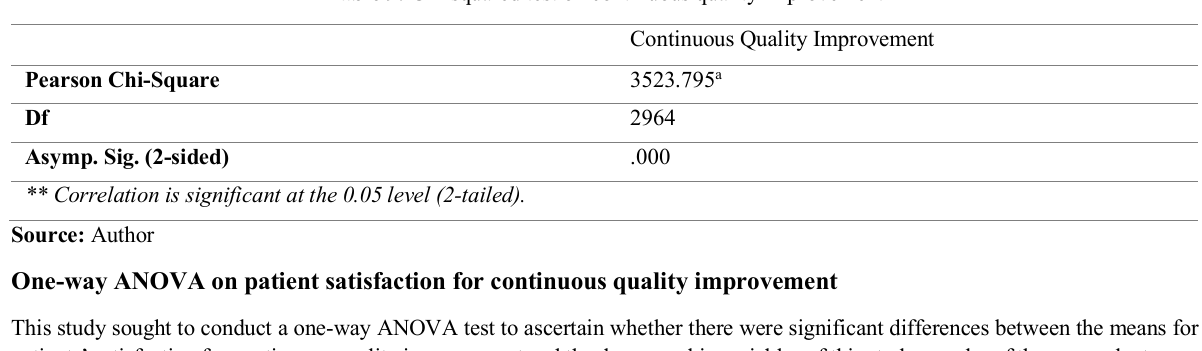
Table 10: One-way ANOVA on patient satisfaction for the continuous quality improvement